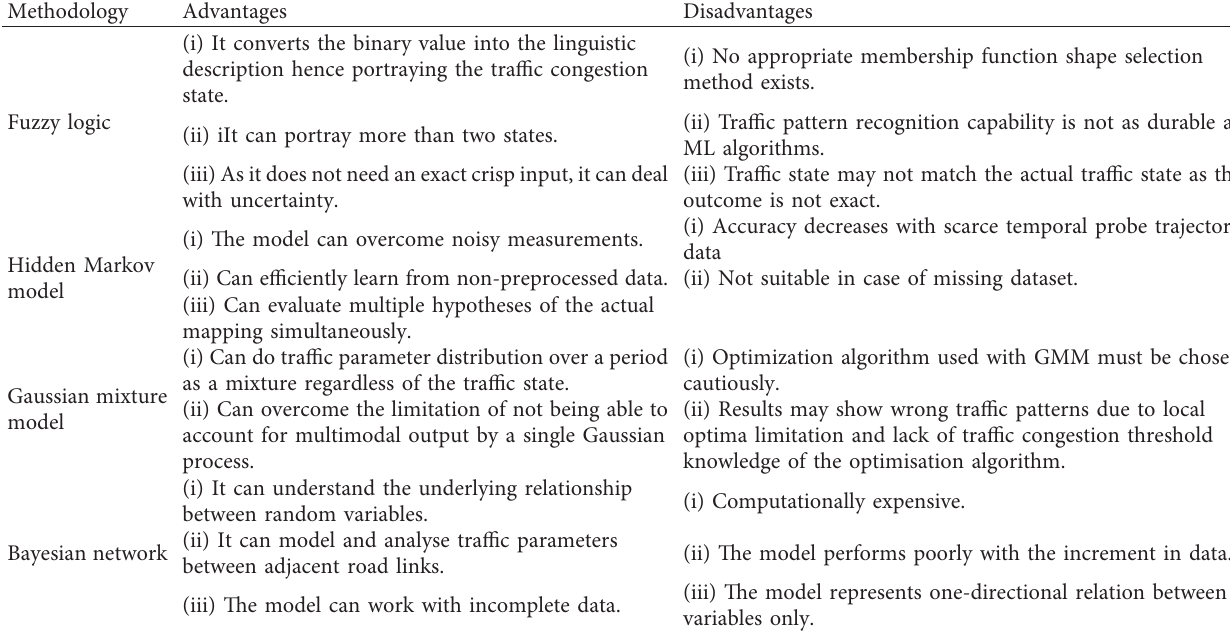
Table 4: The strength and weakness of the models of probabilistic